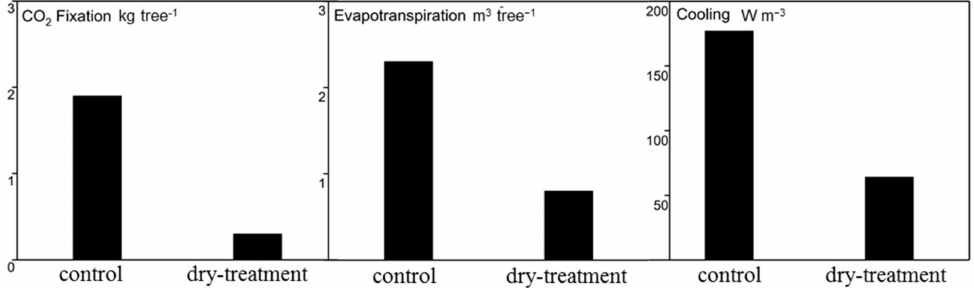
Figure 9. Ecosystem services, including CO 2 fixation, evapotranspiration and cooling potential by transpiration, for trees of the control and treatment groups in the year